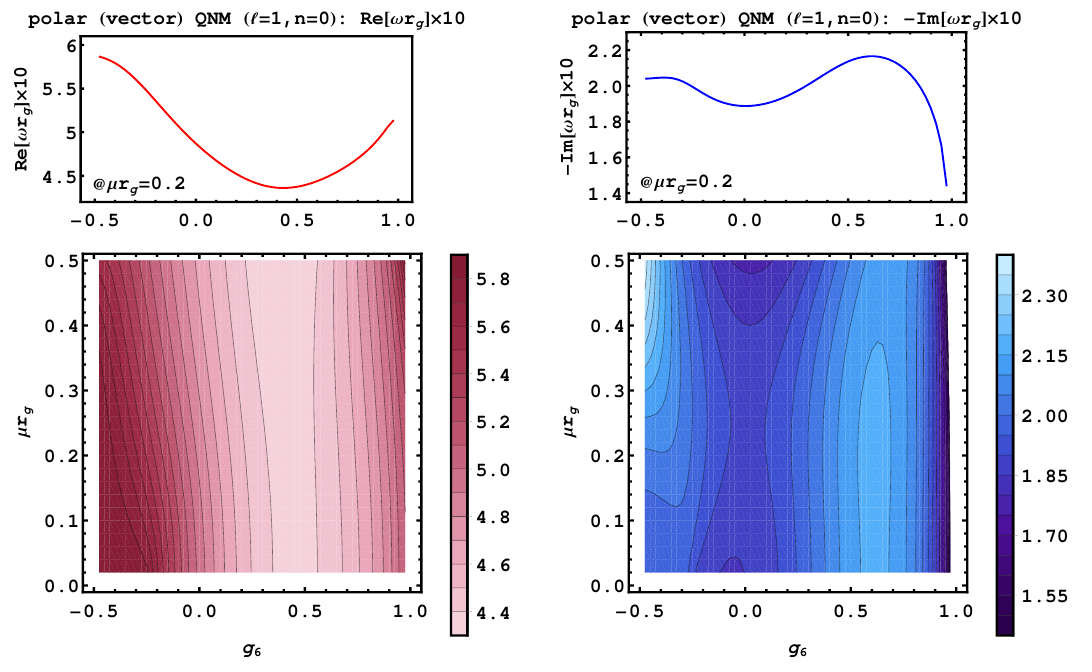
Figure 4 . Polar (vector): real (left-hand panels) and imaginary (right-hand panels) part of the fundamental ( n = 0 ) first multipole ( ‘ = 1 ) QNM in the g 6 – µ plane (lower panels) and as a function of g 6 at µ r g = 0 . 2